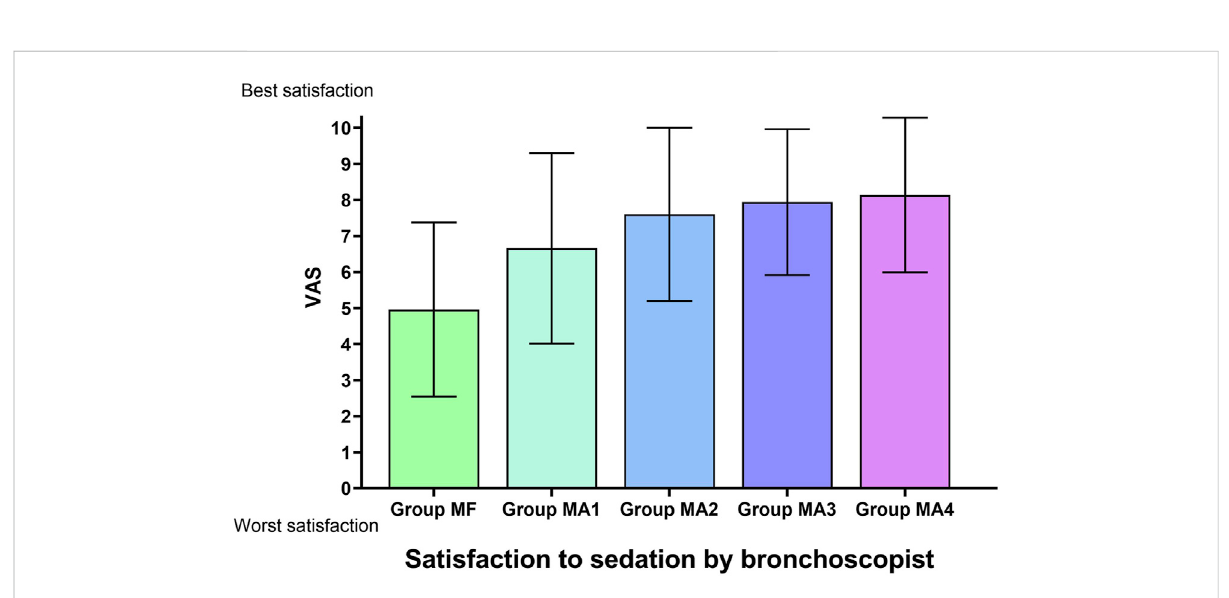
FIGURE 6 Satisfaction to sedation by bronchoscopist in fi ve